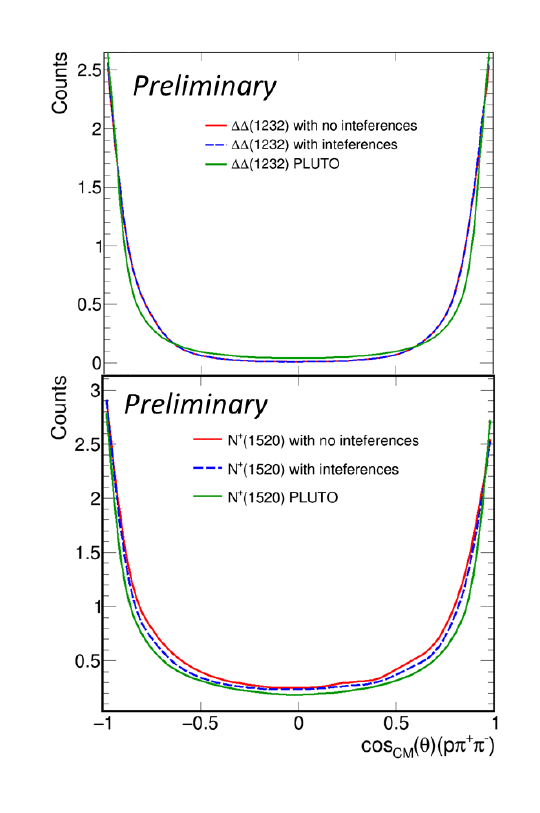
Figure 7. Comparison of the results of a Lagrangian model with (blue) and without (red) interferences between the di ff er- ent graphs. The simulations with the resonance model are shown in green. Top: Distribution of the ( p π + ) centre of mass angular distribution for the double ∆ ++ (1232) contribution. Bottom: Dis- tribution of the ( p π + π − ) centre of mass angular distribution for excitation of the N + (1520) decaying into p π + π − .